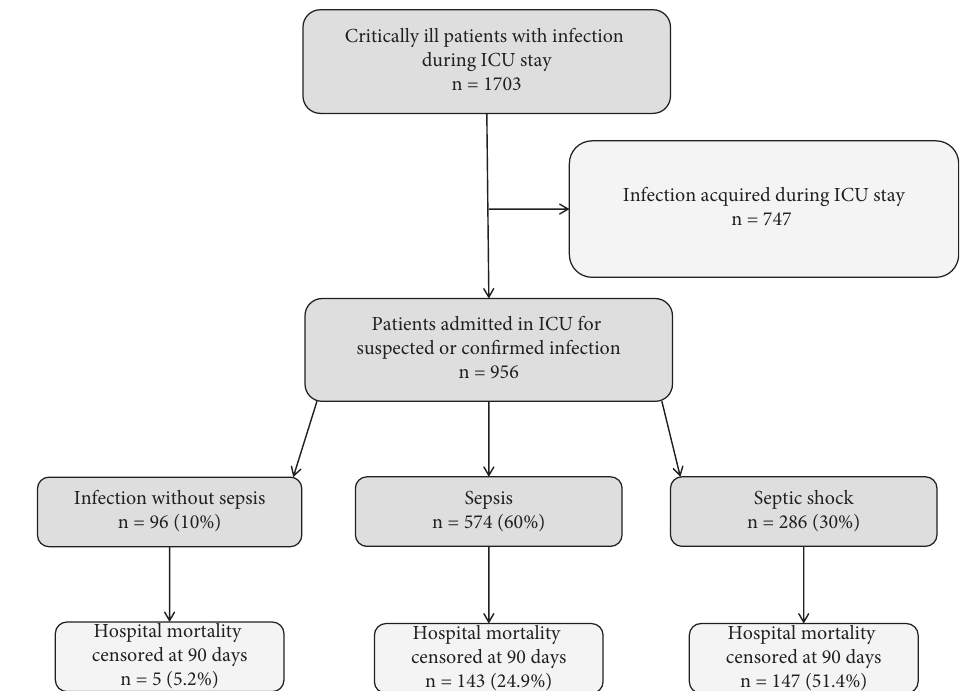
Figure 1: Number of patients who were screened and finally included in the analysis. ICU, intensive care